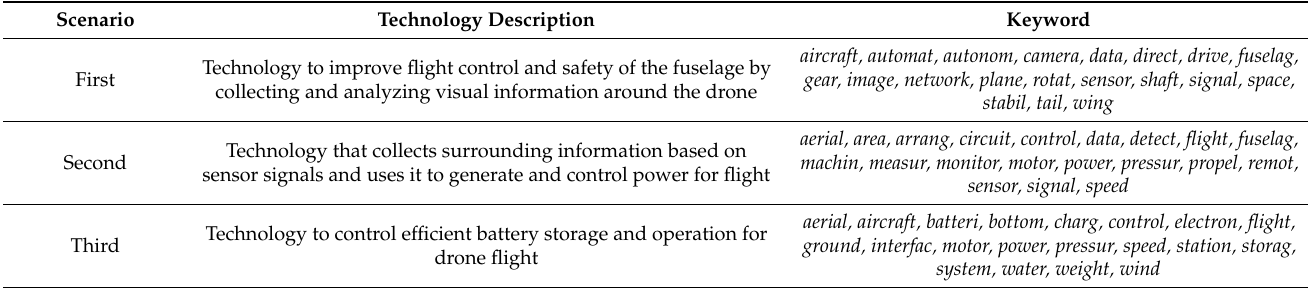
Table 7. Technology scenarios for drones.